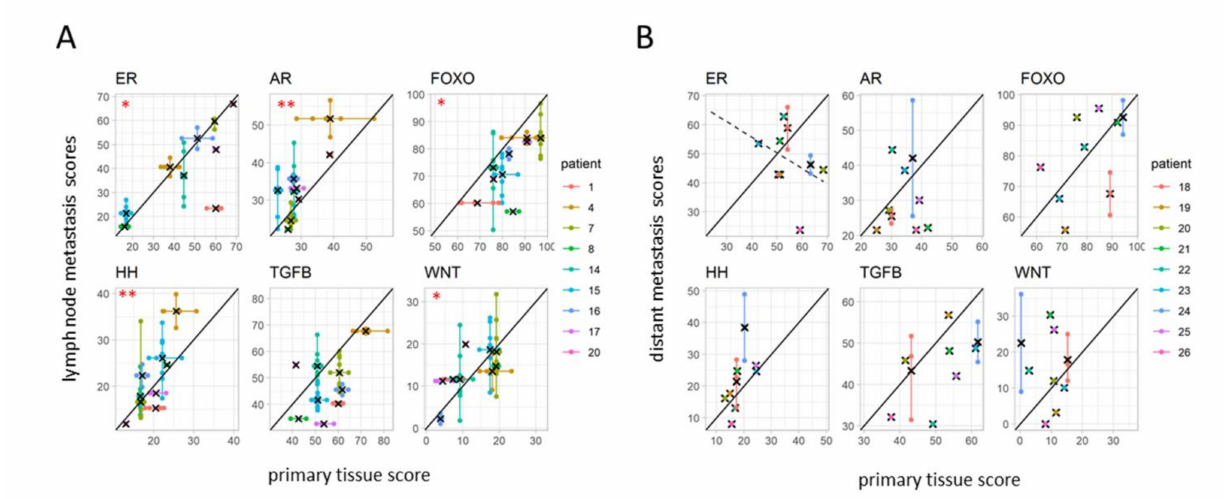
Figure 5. Heterogeneity in signaling pathway activity between primary tumor and metastases ( A ) Correlation between measured pathway activity scores in primary (x-axis) tumor and matched lymph node metastases (y-axis) visualized by plotting pathway activity scores (Sample sets IV and II/III). ( B ) Correlation between measured pathway activity score in primary tumor (single sample) and matched distant metastases (Sample set III). Per plot, colors indicate samples that belong to one patient (patient IDs indicated in the legends), the cross indicates the average, and the black line is a visual guide for a one-to-one relation. Significance level for the correlation between mean scores are indicated by stars (*: p < 0.05, **: p < 0.01, corresponding values are in Table